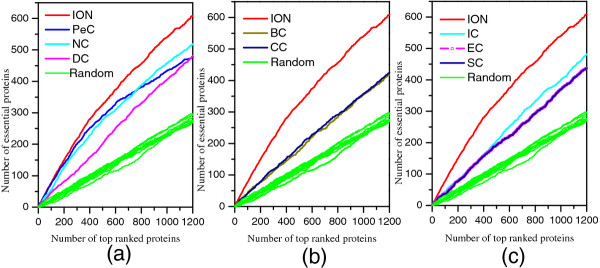
Jackknife curves of ION and eight other existing centrality methods. The x-axis represents the proteins in PPI network ranked by ION and eight other existing centrality methods, ranked from left to right as strongest to weakest prediction of essentiality. The Y-axis is the cumulative count of essential proteins encountered moving left to right through the ranked. The areas under the curve for ION and the eight other existing centrality methods are used to compare their prediction performance. In addition, the 10 random assortments are also plotted for comparison. (a) shows the comparison results of ION, PeC, NC and DC. (b) shows the comparison results of ION and two global centrality methods: BC and CC. (c) shows the comparison results of ION and other three centrality methods: IC, EC and SC.